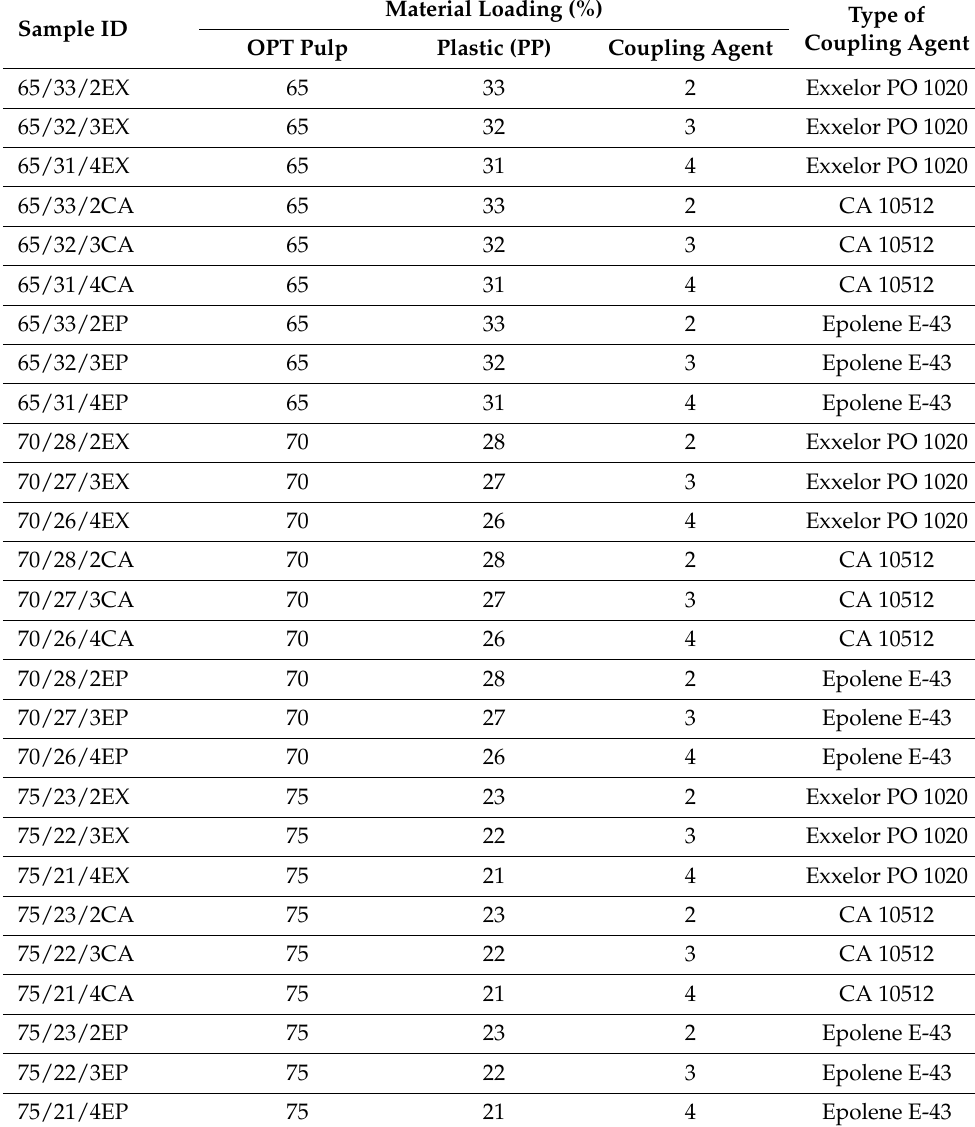
Table 3. Formulation used in producing the PP/OPTP